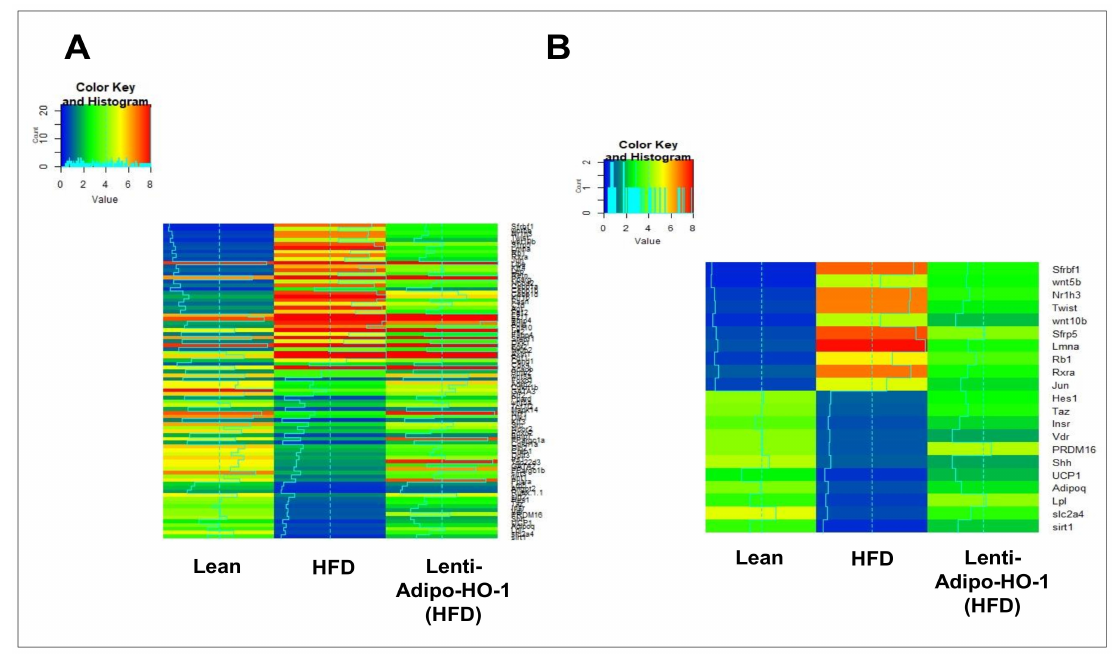
Figure 9. RNA-array-analyses changes in correlation coe ffi cients gene expression in lean, HFD, and Lnv-adipo-HO-1 (HFD) groups. ( A ) RNA-array-analyses changes in correlation coe ffi cients gene expression of 86 genes involved in Fat Metabolism. ( B ) RNA array analysis showing changes in correlation coe ffi cients for gene expression of sfrbf1, Wnt5b, Nr1h3, Twist, Wnt10b, Sfrp5, Lmna, Rb1, Rxra, Jun, Hes1, Taz, Insr, Vdr, PRDM16, Shh, UCP1, Adipoq, Lpl, Slc2a4, and Sirt1 in mice injected with Lnv-adipo- HO-1.